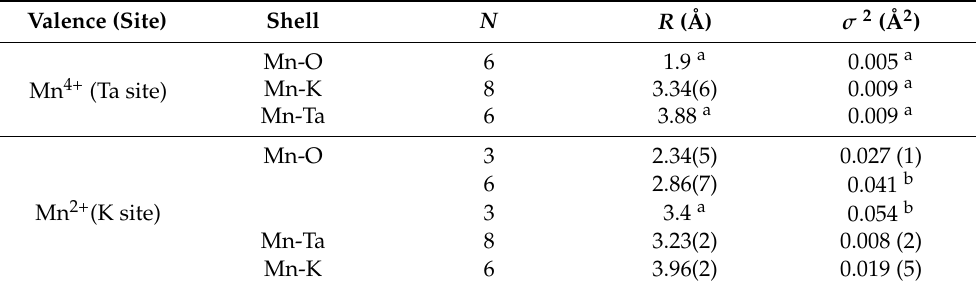
Table 2. Parameters of the Mn coordination environment in K 0.985 Mn 0.015 TaO 3 ± δ as obtained